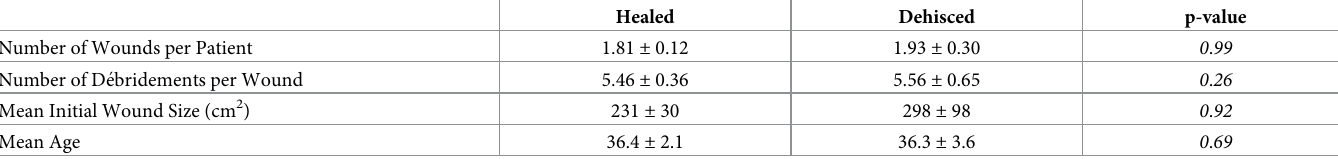
Healed Dehisced p-value